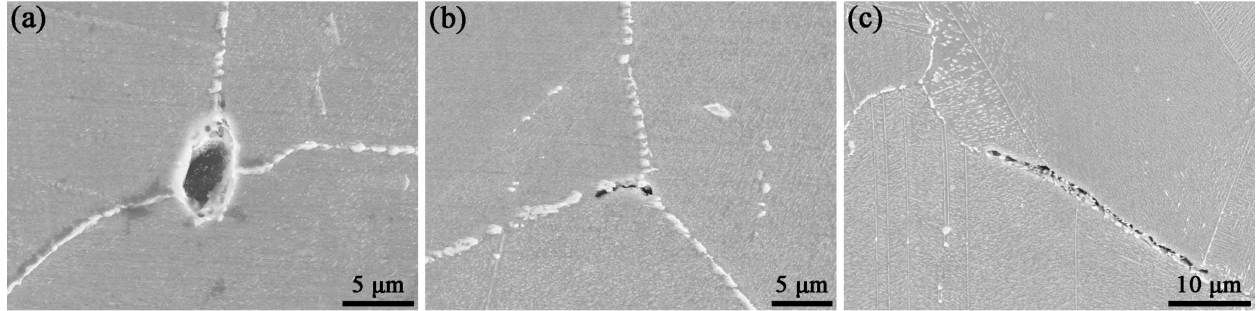
Figure 13. Grain boundary damages of the sample under C–F test ( t h = 60 s) at 800 ◦ C: ( a ) micro-void; ( b , c )